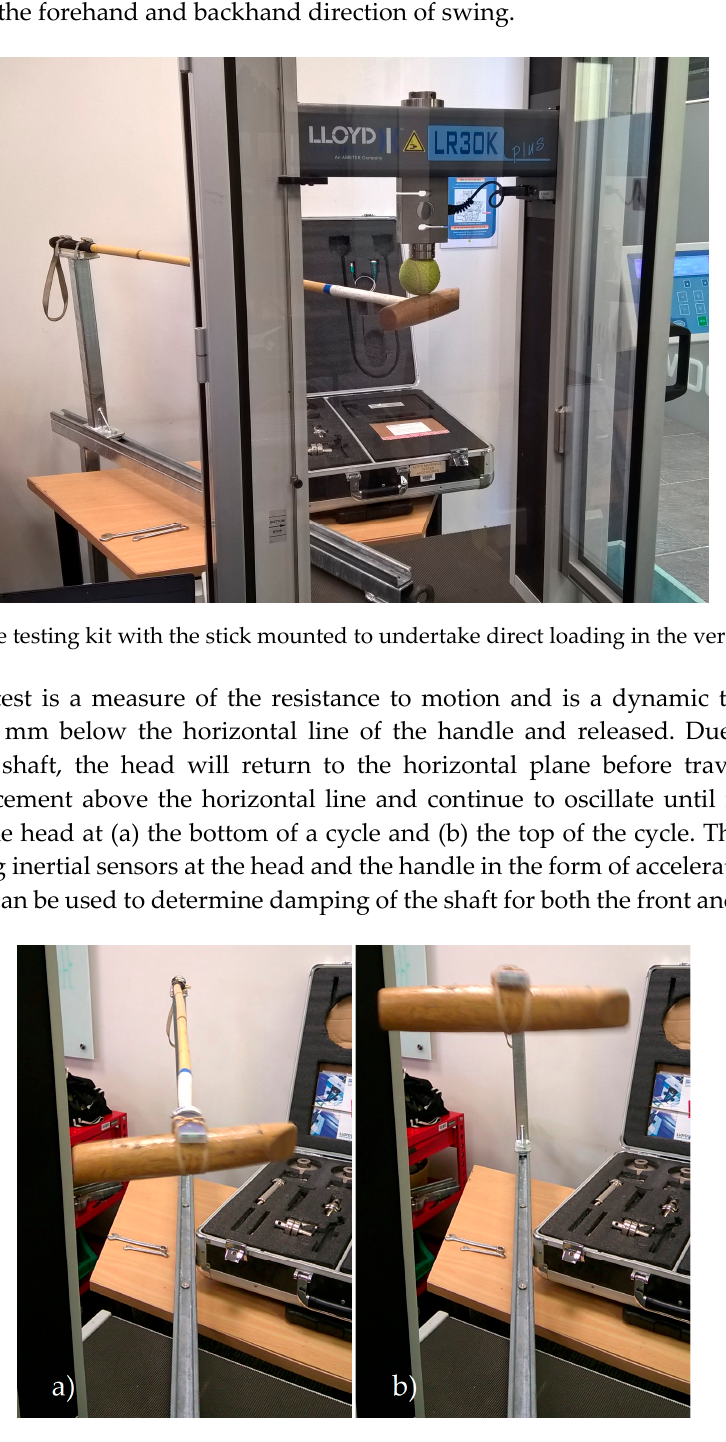
Figure 5. The stick in motion after release, ( a ) bottom of deflection cycle and ( b ) top of deflection